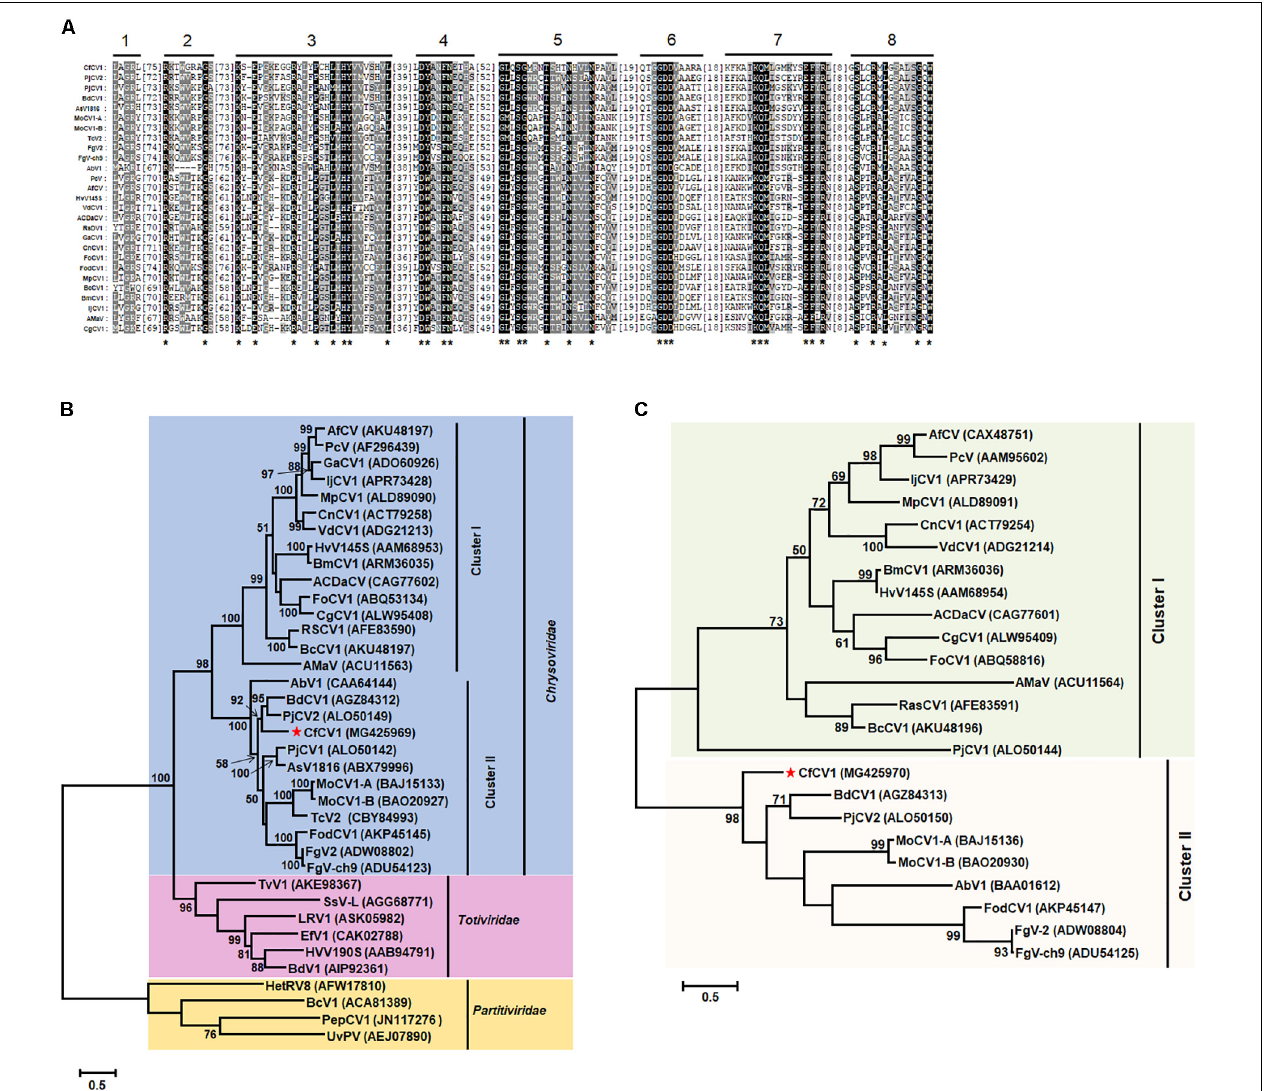
FIGURE 4 | Phylogenetic analysis of CfCV1. (A) Multiple sequence alignments of RdRp in CfCV1 and other members of the family Chrysoviridae . The alignments were produced in MAFFT and visualized using the BoxShade program. “ ∗ ” indicates identical amino acid residues. (B) Maximum likelihood phylogenetic tree constructed using the complete amino acid sequences of the RdRp of CfCV1 and other selected Chrysoviridae , Partitiviridae , and Totiviridae members. (C) Maximum likelihood phylogenetic tree constructed using the complete amino acid sequences of the CP of CfCV1 and other selected members of the family Chrysoviridae. The red star indicates the position of CfCV1. The trees were computed based on the best-fit model of protein evolution (LG + G + I + F). The Gamas values were 3 (RdRp) and 2 (CP). Bootstrap values (relative) generated using 1000 replicates are shown on the branches. Only ≥ 50% bootstrap values are shown, and branch lengths are proportional to the genetic distances. Virus name abbreviations and GenBank accession numbers are provided in Supplementary Table S1.